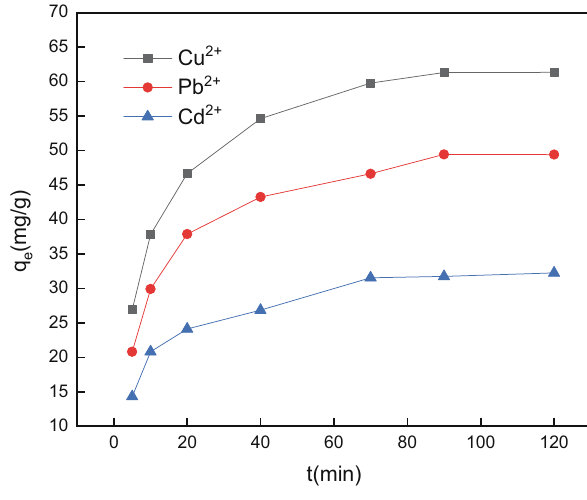
Figure 4: E ff ect of dosage on the adsorption of Cu 2 + , Pb 2 + , and Cd 2 + by GC.